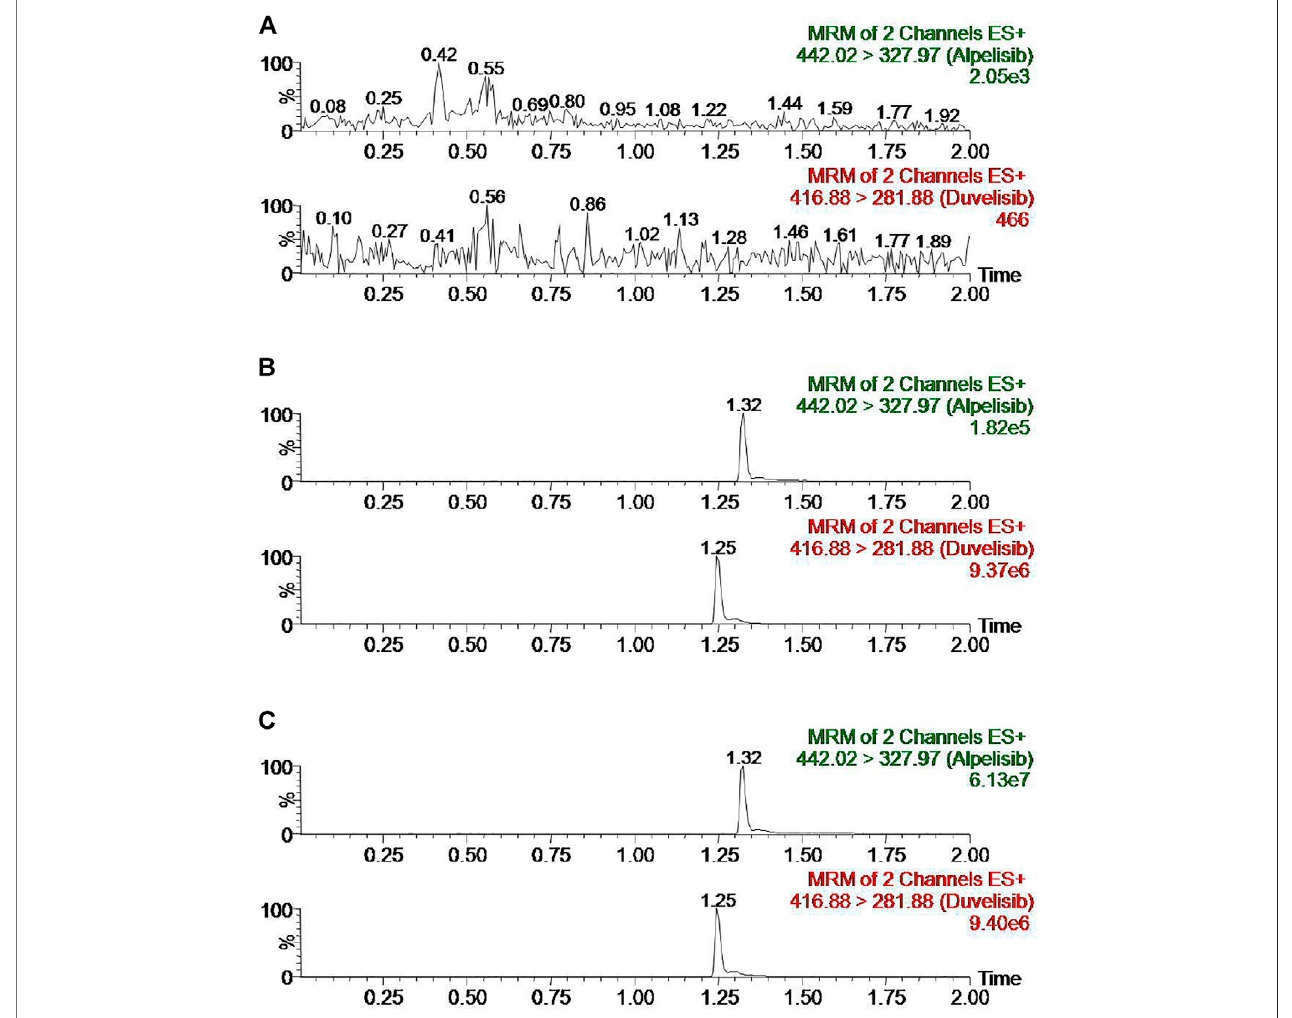
FIGURE 2 | Representative chromatograms of alpelisib and IS in rat plasma: (A) blank plasma; (B) blank plasma spiked with standard solution at 10 ng/ml and IS; (C) sample obtained from a rat at 3.0 h after oral administration of alpelisib (30 mg/kg).